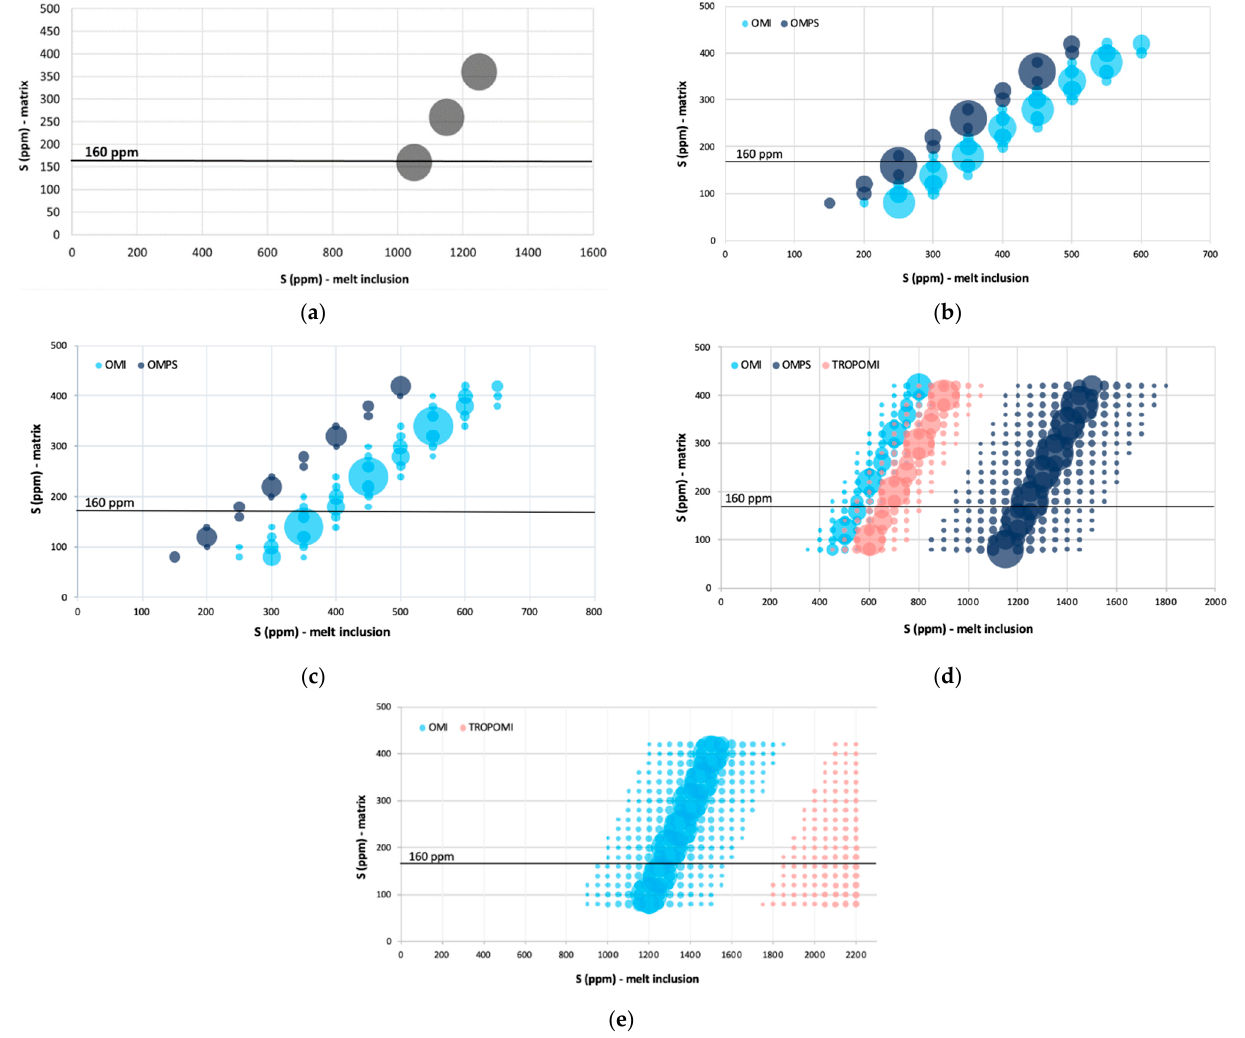
Figure 7. ( a – e ) Estimation of sulfur content within melt inclusions using the reverse petrological approach. The larger the symbol, the better the match with the total SO 2 mass detected by the UV satellite sensors. According to petrological analysis, the average residual sulfur content in the matrix can be fixed at 160 ppm [33]. This is represented by the black line. Note that for the April 2007 eruption, the sulfur content estimation used the seismically-derived TADR data from Duputel and Rivera (2019) [34] and the three points corresponding to the following S couples (MI—Matrix: 1050—160 ppm; 1150—260 ppm; 1250—360 ppm), provide exactly the total SO 2 mass estimated from the direct petrological approach. Results are given with 45% uncertainty. ( a ) April 2007; ( b ) May 2015;